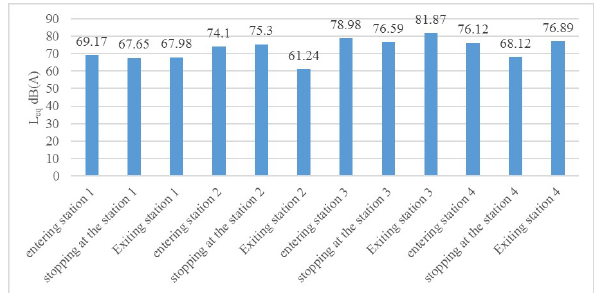
Figure 2: L eq values in 4 stations